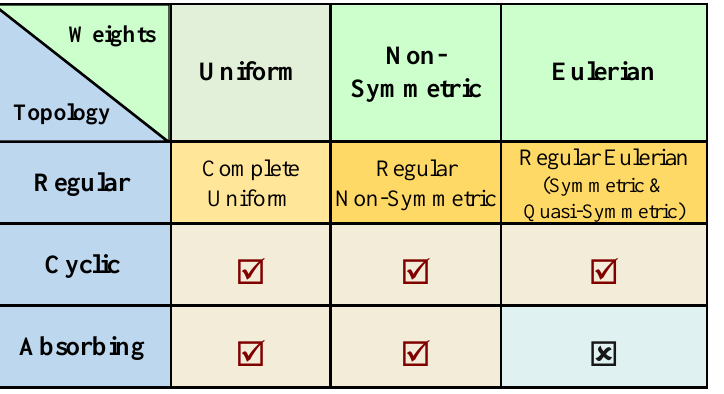
Figure 3. The general classification of networks. The focus of the study is the top row of the table. It lists the classes of networks under